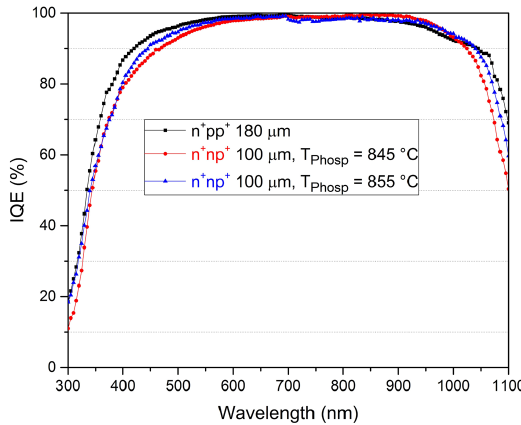
Figure 5. Internal quantum efficiency (IQE) of n + np + thin solar cells with the highest efficiency and of the n + pp + thick standard device.